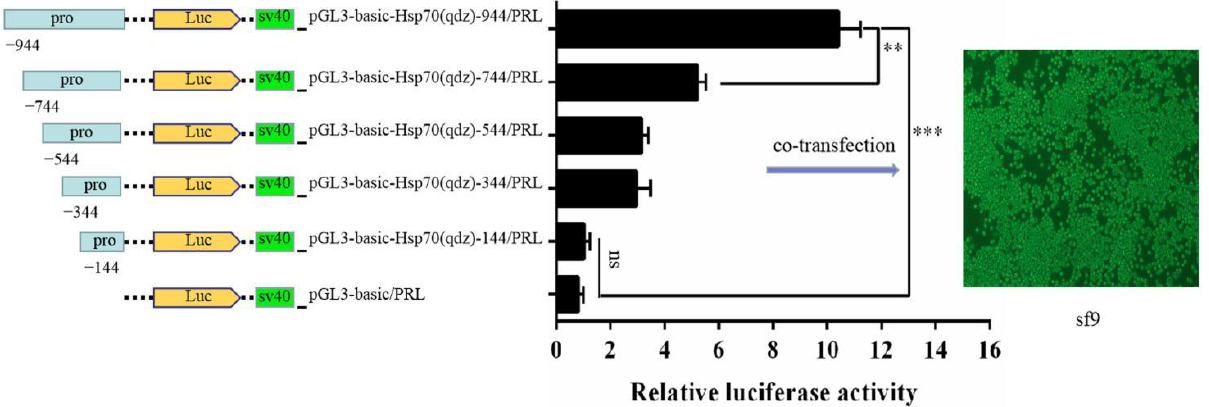
Figure 2. Analysis of the luciferase activity of truncated sequences of AhHsp70 p. In this experiment, Spodoptera frugiperda (Sf9) cells were used for the stable expression of AhHsp70 in vitro. Sf9 cells were transfected with recombinant plasmids containing AhHsp70 p sequences of differing deletion length or pGL3-Basic and pRL-TK as controls for 48–96 h and the cells were harvested for the luciferase activity assay. qdz represents the AhHsp70 promoter. All values are shown as the mean ± SD. The data were analyzed using the Student’s t -test. ** p < 0.01, extremely significant; *** p < 0.001, extremely extremely significant; ns, not significant.